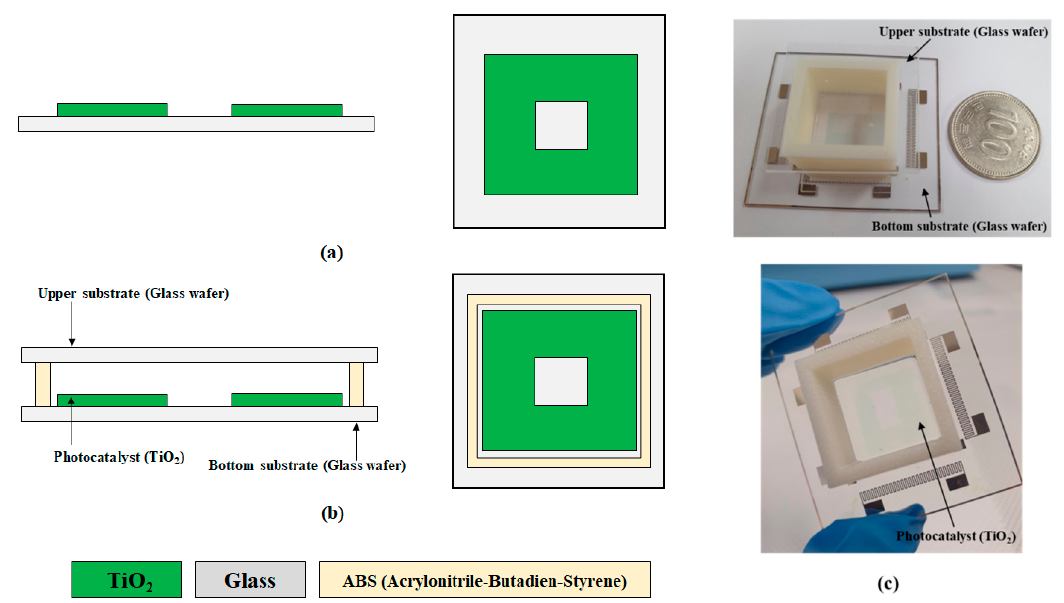
Figure 5. ( a ) Schematic and ( b ) picture of the miniaturized portable TP analysis device with the TP sensor.